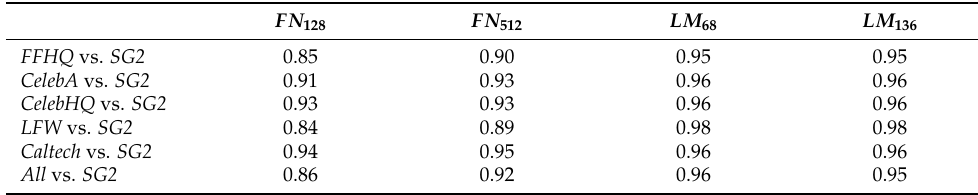
( a ) ROC for LM 68 . ( b ) ROC for LM 136 . Figure 13. Comparison of the ROC curves obtained with the SVM model using landmark-based features. Table 3. AUC values for the SVM